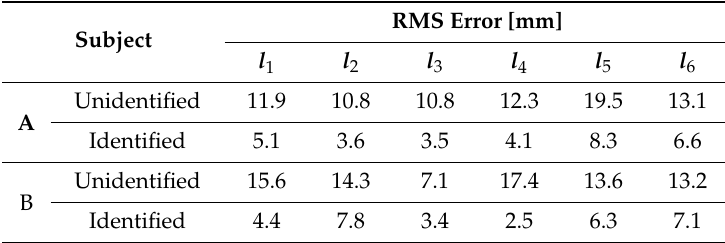
Table 3. RMS errors of l i between captured results and calculated results based on identified / unidentified models.